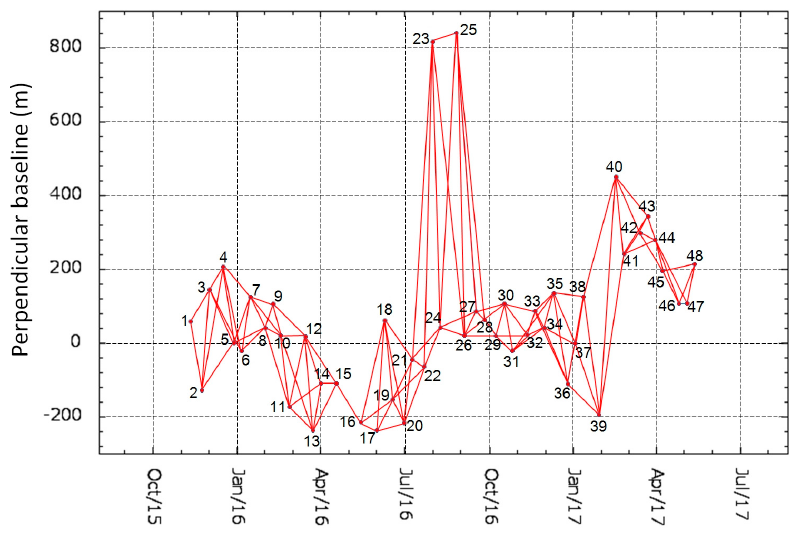
Figure 4. Baselines used to generate interferograms for SBAS processing.